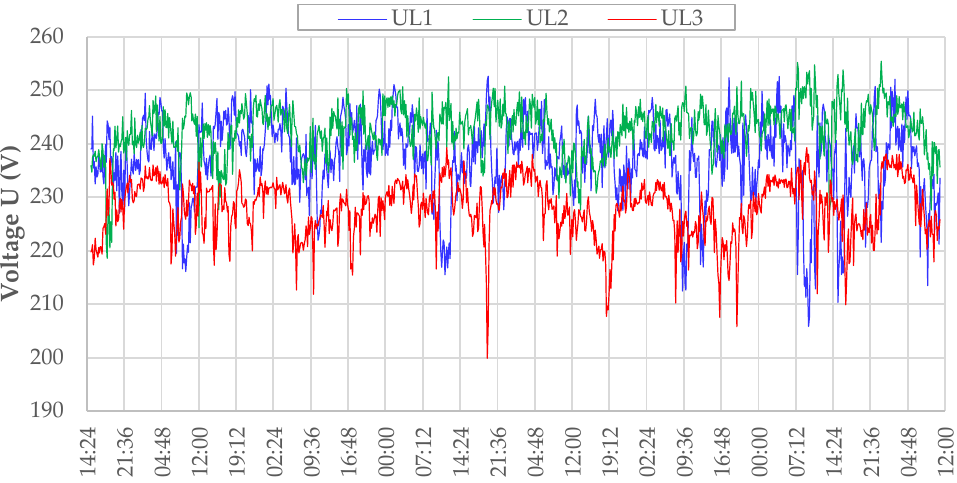
Figure 8. Voltage measurements according to standard EN 50160 at Object 1 (three phases, average of 10-min intervals).